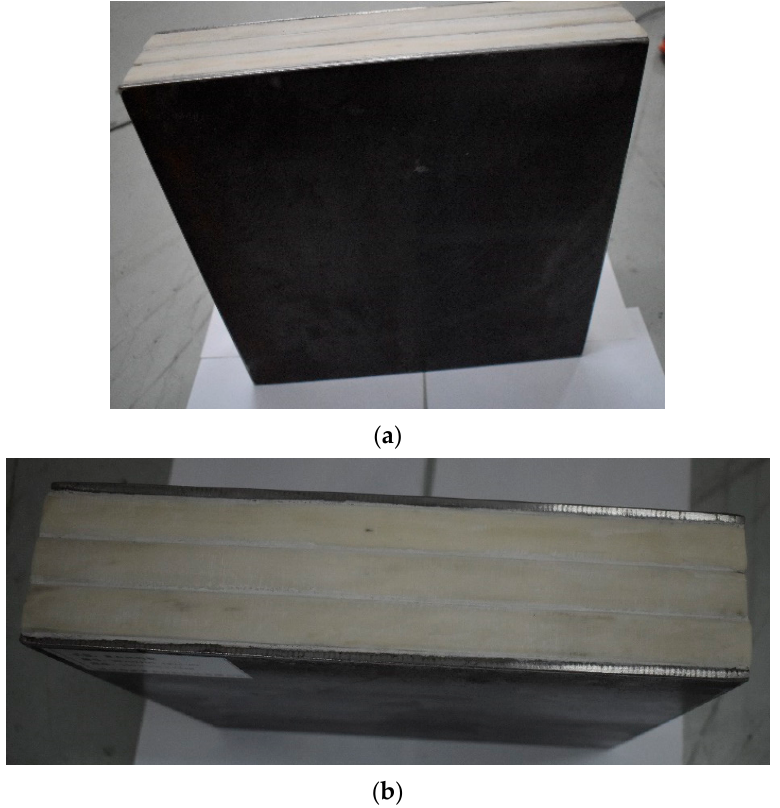
Figure 7. Photograph of the armors in the test. ( a ) Front view. ( b ) Side view.